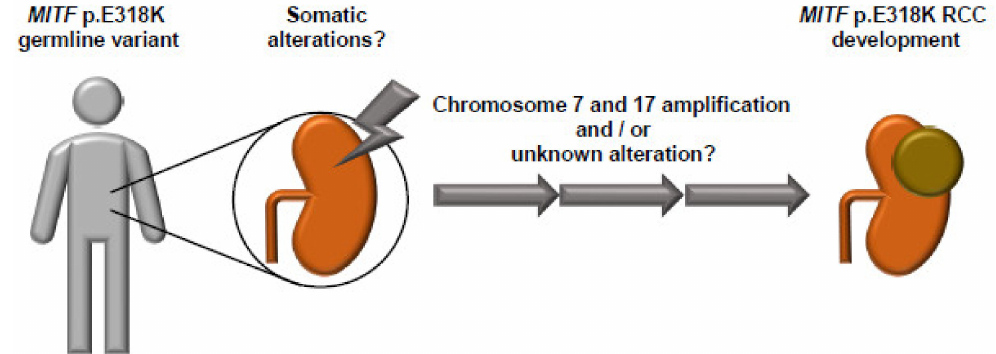
Figure 3. Hypothetical model of MITF p.E318K RCC development. The MITF p.E318K germline variant is a mild susceptibility allele. In addition to the germline variant, somatic alterations such as chromosome 7 and 17 amplification, unknown gene mutations, or epigenetic alteration might be required for MITF p.E318K RCC